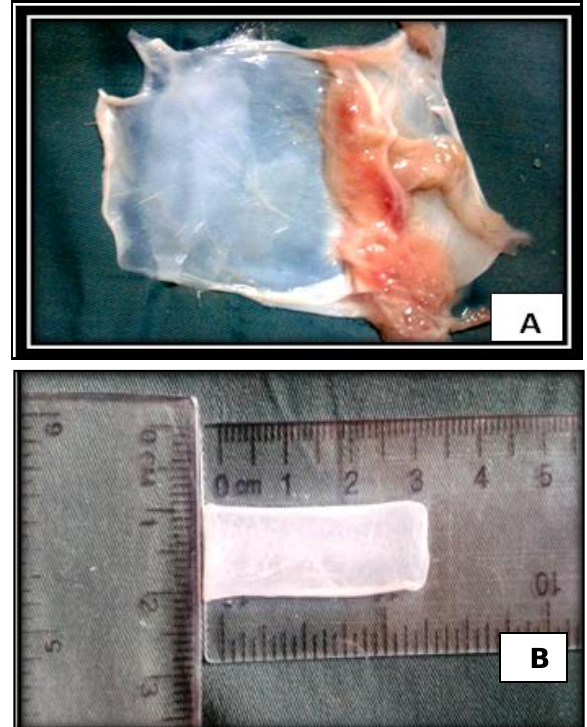
Fig.1: Shows steps of pericardial extracellular matrix preparation. (A) Manually cleansing of pericardium. (B) Trimmed pericardium (1x3